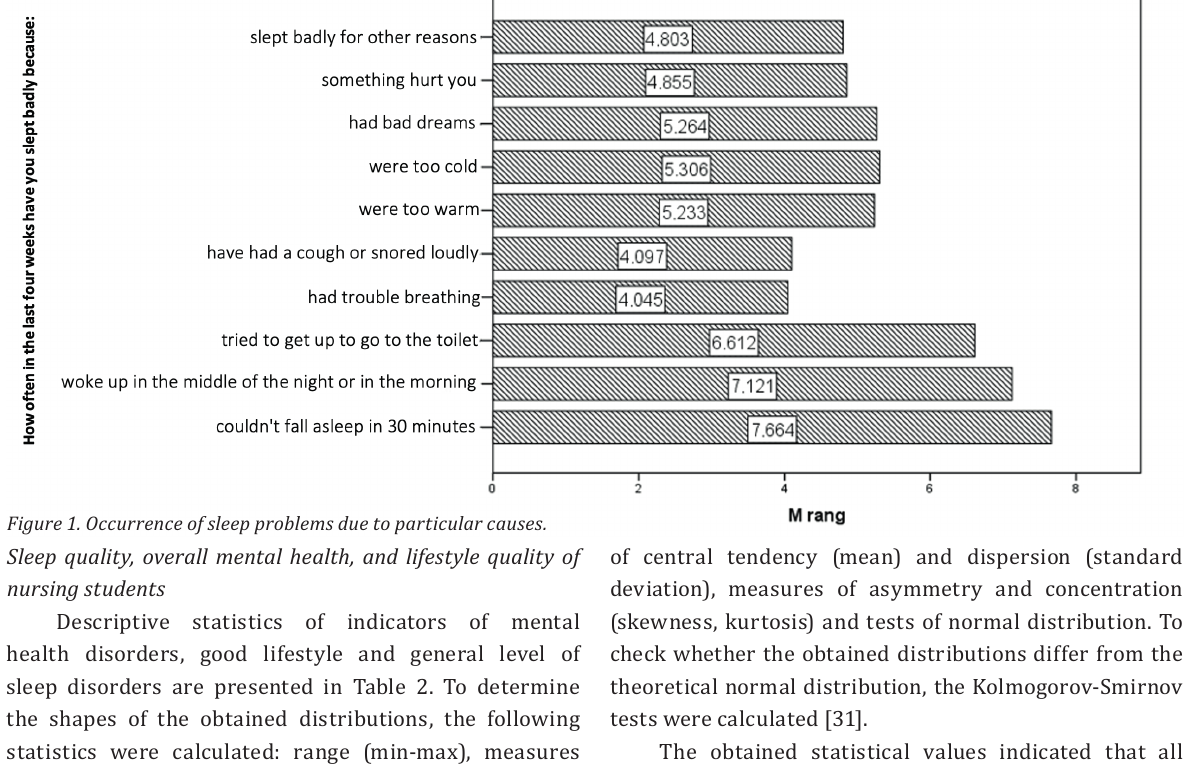
Table 2. Descriptive statistics for indicators of mental health disorders, positive lifestyle and general level of sleep disorders (N =